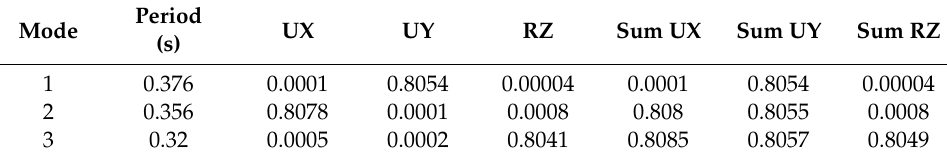
Table 12. Ratios of the modal participating mass ratios after the reducing of the torsion.